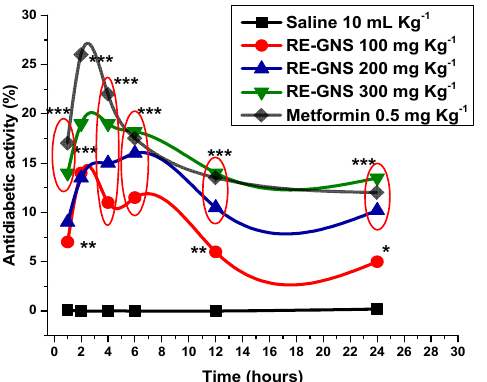
Figure 9. Antidiabetic effect of various doses of REEW-GNs at different time intervals: percent reduction in blood glucose level (BGL) is represented as mean ± SEM of n = 6 at p < 0.05. OWANOVA revealed significant to highly significant BGL reduction compared to saline. ** and *** represent highly significant effect compared to saline ( p < 0.01), * represents significant effect ( p < 0.05) where NS represents statistically non-significant differences among the treatments.